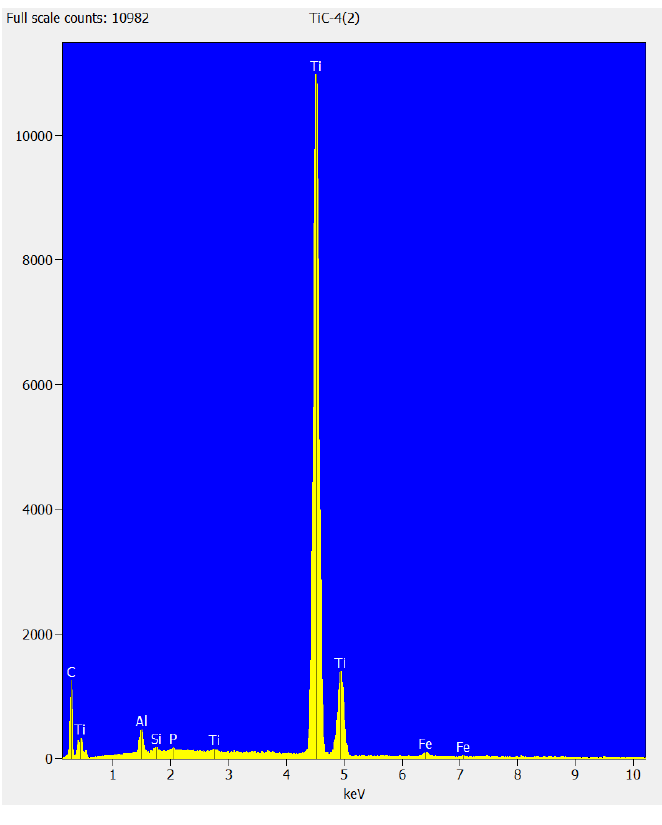
Figure 4. Energy Dispersive Spectroscopy (EDS) spectrum obtained from the surface of the TiC-1000 sample.